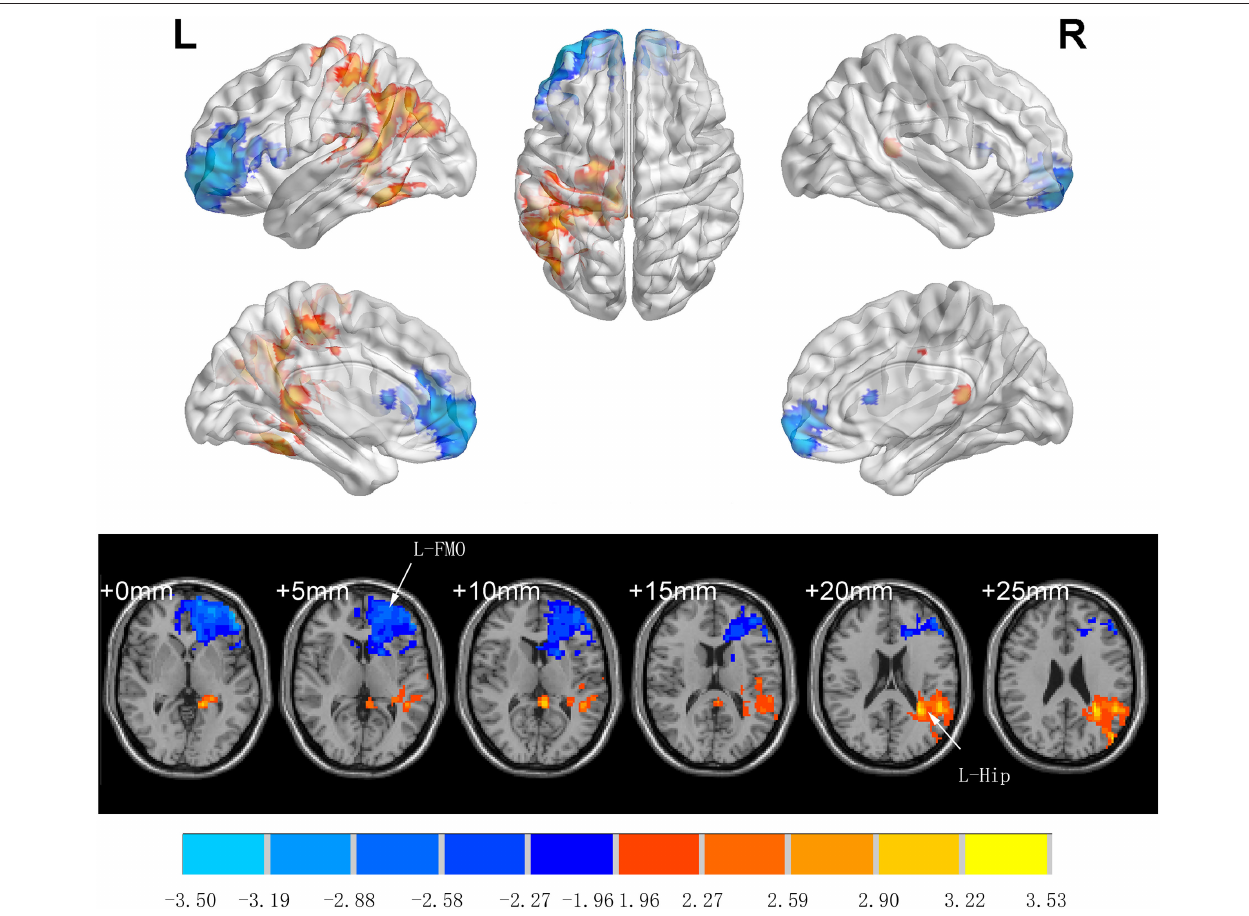
FIGURE 3 | Significant differences in ALFF between Groups I and C 7 days after surgery (voxel p < 0.05, GRF-corrected). Increased ALFF was observed in the left middle temporal gyrus, left precentral gyrus, left paracentral lobule, left hippocampus, left parahippocampal gyrus and left precuneus, decreased ALFF was observed in the left orbital middle frontal gyrus, left orbital superior frontal gyrus, and left medial superior frontal gyrus between Group I and Group C. ALFF, amplitude of low-frequency fluctuation; GRF, gaussian random field.